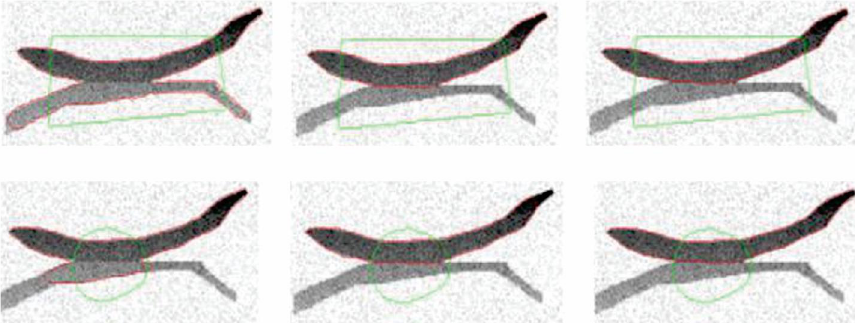
FIG. 2. SEGMENTATION EFFICIENCY OF THREE METHODS AGAINST TWO DIFFERENT INITIALIZATIONS ON SYNTHETIC IMAGE (LEFT) LOCALIZATION METHOD (MIDDLE) YIN’S METHOD (RIGHT) PROPOSED METHOD, GREEN IS INITIALIZATION AND RED IS FINAL SEGMENTATION